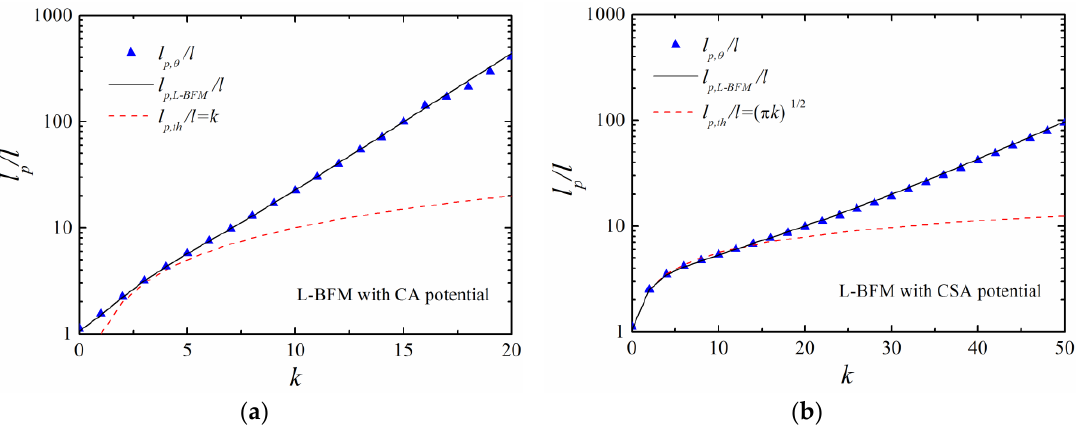
Figure 10. The theoretical persistence lengths in Larson-type BFM and continuous simulations and simulation results l p,θ with ( a ) CA and ( b ) CSA potentials, respectively. The length of the chain is N = 50.